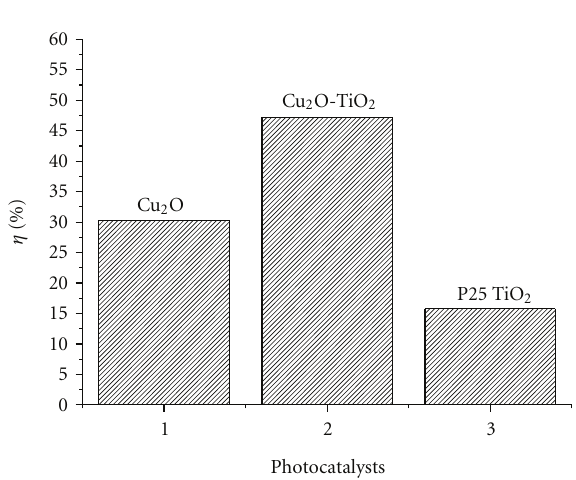
Figure 5: Photocatalytic activities of di ff erent photocatalysts under visible-light irradiation (the Cu 2 O-TiO 2 sample was prepared at a thermal reduction temperature of 160 ◦